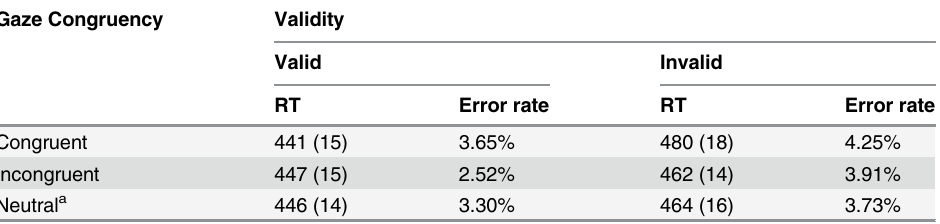
Table 1. Group average RTs and error rates Experiment